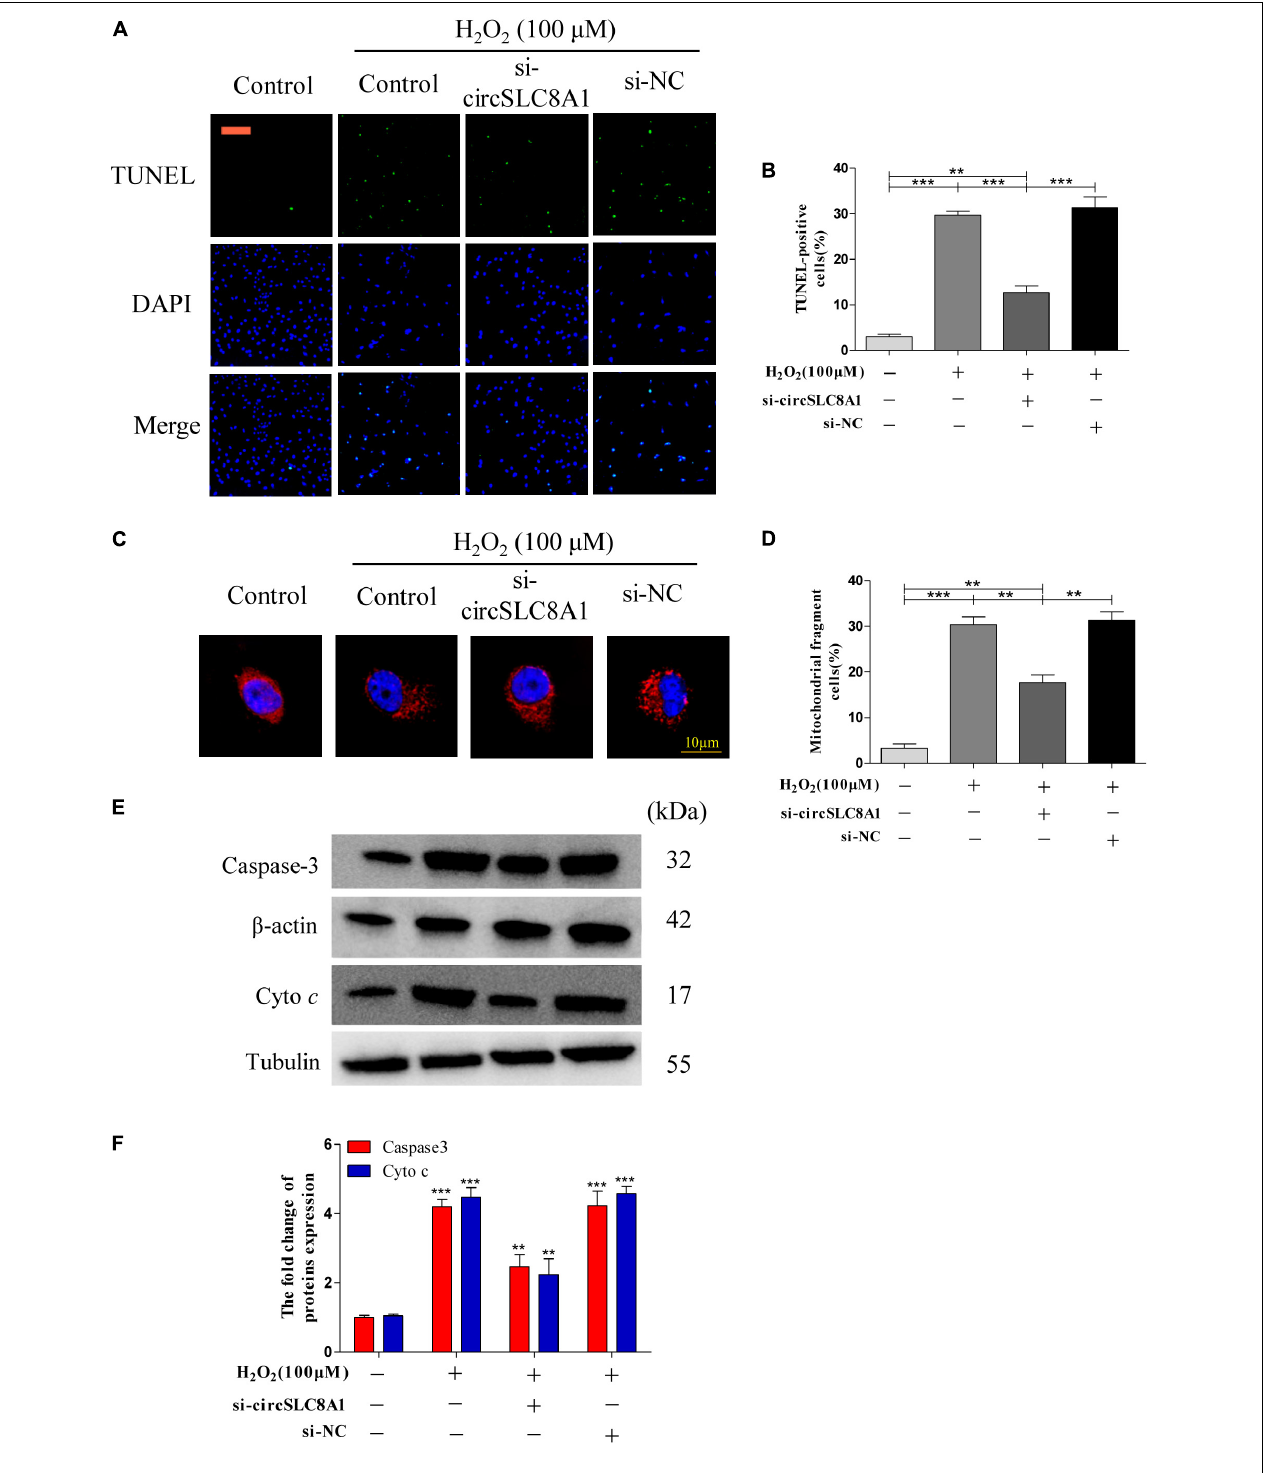
FIGURE 8 | Knockdown circSLC8A1 reduced myocardial cell to apoptosis under oxidative stress. (A) AC16 cells were exposed to 100 µ M H 2 O 2 for another 12 h after transfected with circSLC8A1-siRNA for 24 h, and apoptosis was stained with TUNEL. (B) The percentage of cells underwent TUNEL-positive cell. (C) AC16 cells were exposed to 100 µ M H 2 O 2 for another 12 h after the knockdown of circSLC8A1 expression, and the mitochondria was stained with MitoTracker Red. (D) The percentage of cells underwent mitochondrial fission. (E) The expression levels of apoptotic-related proteins were detected by western blotting. (F) The data analysis of blot densitometry. All the data were expressed as the mean ± SEM of three independent experiments. * P < 0.05, ** P < 0.01, *** P < 0.001.